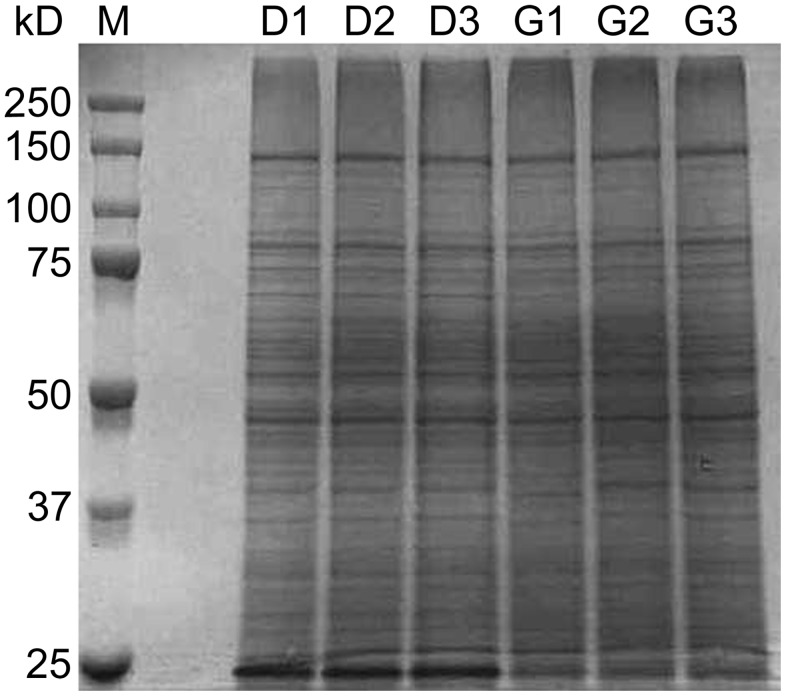
Gel electrophoresis of membrane-associated spore proteins.Membrane preparations were obtained from dormant (D) and germinated (G) spores produced from three independent spore preparations (1, 2, and 3). Protein concentrations in membrane preparations were determined by quantitative amino acid analyses, and identical protein amounts were loaded onto a 9% polyacrylamide gel. Sizes of protein standard markers (M) are indicated on the left. Proteins were stained using Coomassie blue.